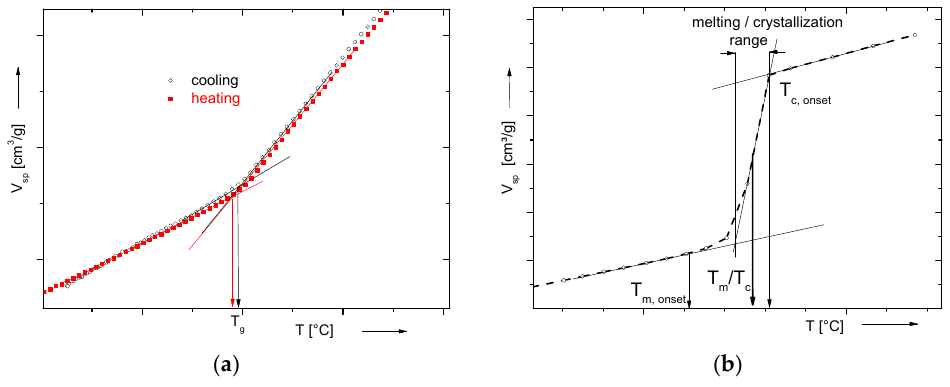
Figure 1. Scheme of determination of ( a ) T g and ( b ) T c or T m from isobars. The GNOMIX pVT apparatus detects only the changes in specific volume (d V sp ) in dependence